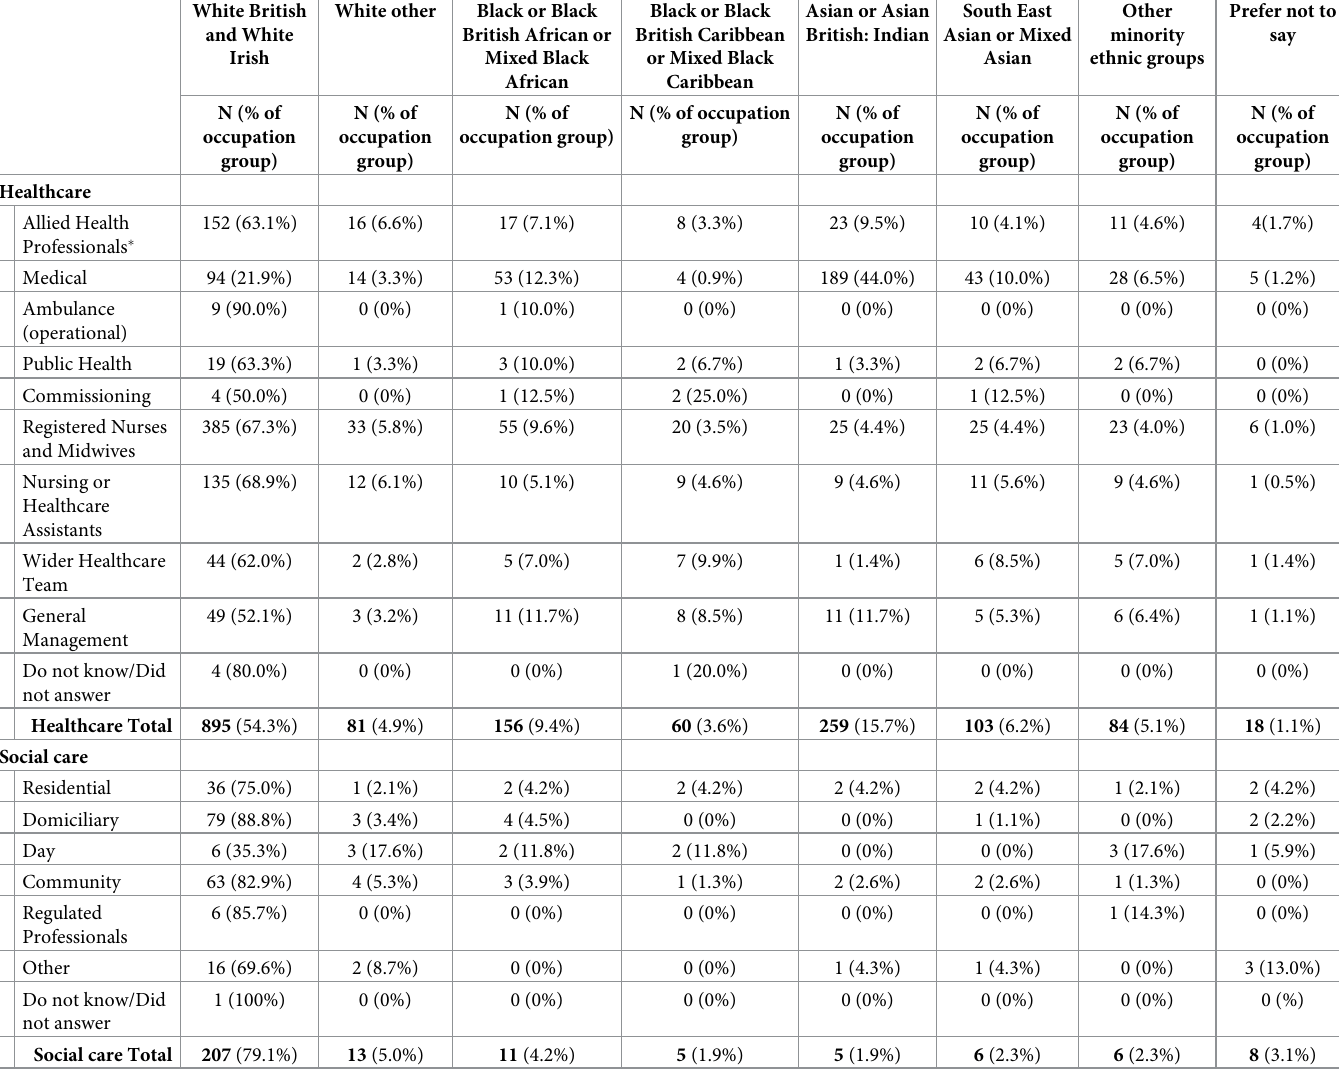
Table 1. Frequency and percentage of sample within occupation group by ethnic minority